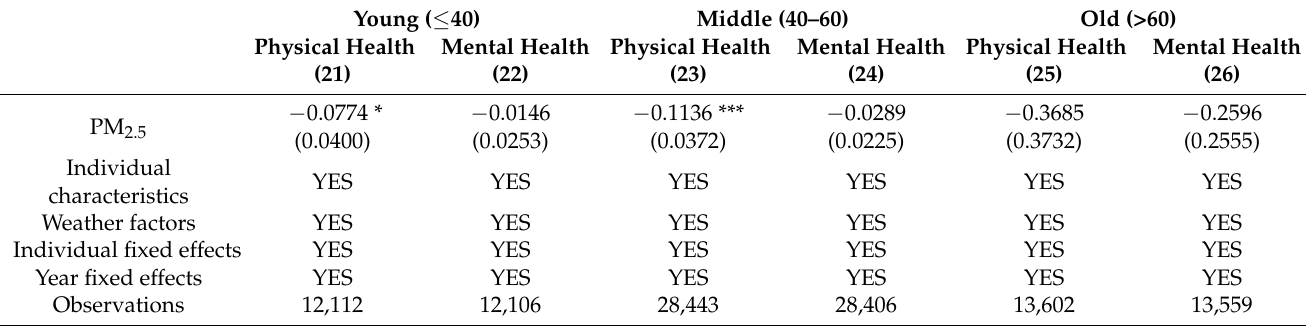
Table 8. Heterogeneity effects with age.